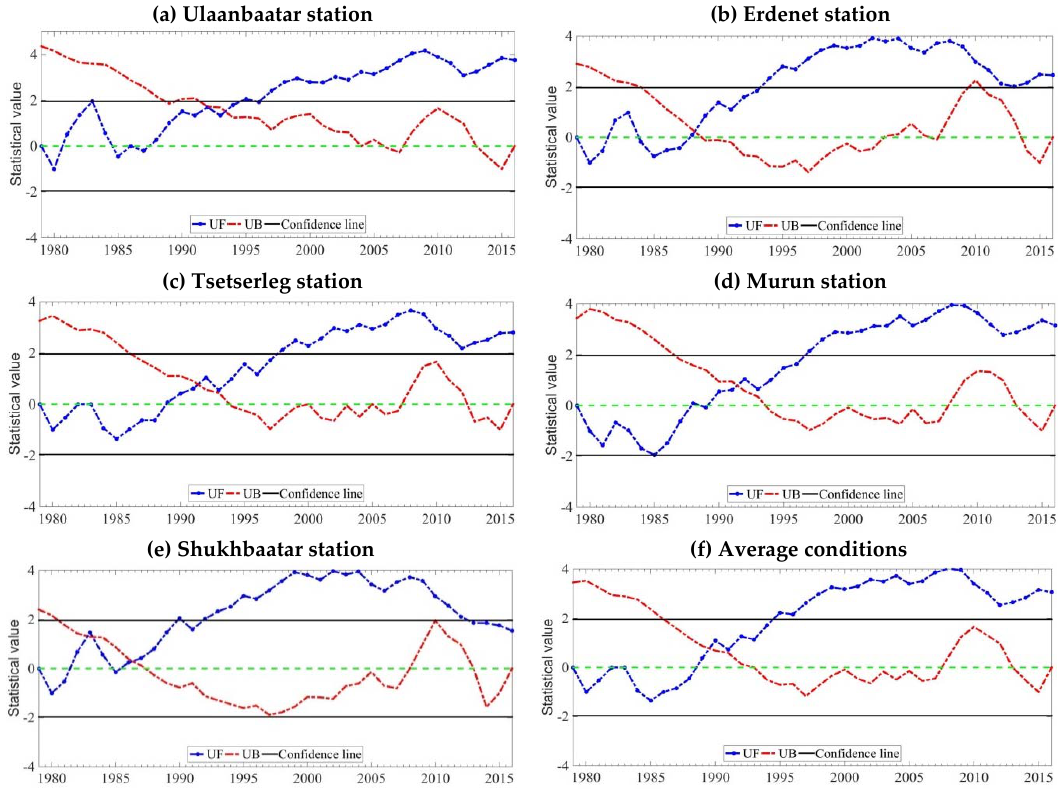
Figure 4. Trends of annual air temperature across stations (note: UF and UB are changing parameters where UB = − UF).